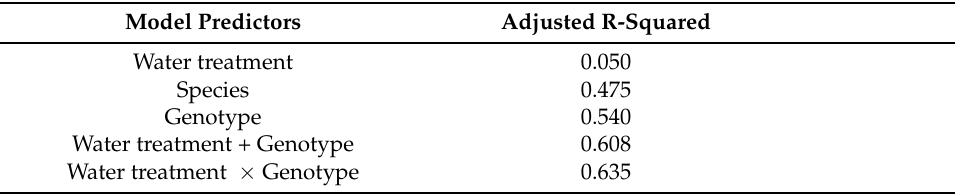
Figure 5. Linear regression tested on the 4 landraces of finger millet, 5 landraces of pearl millet and 5 landraces of sorghum. Total water transpired (L) is used as the independent variable, and % silica extracted from leaves is used as the dependent variable. Gray bands represent 95% confidence intervals. Table 2. Comparison of linear and multiple linear regression models to account for silica accumulation variability (% of silica extracted) in the dataset, including the three species of finger millet, pearl millet and